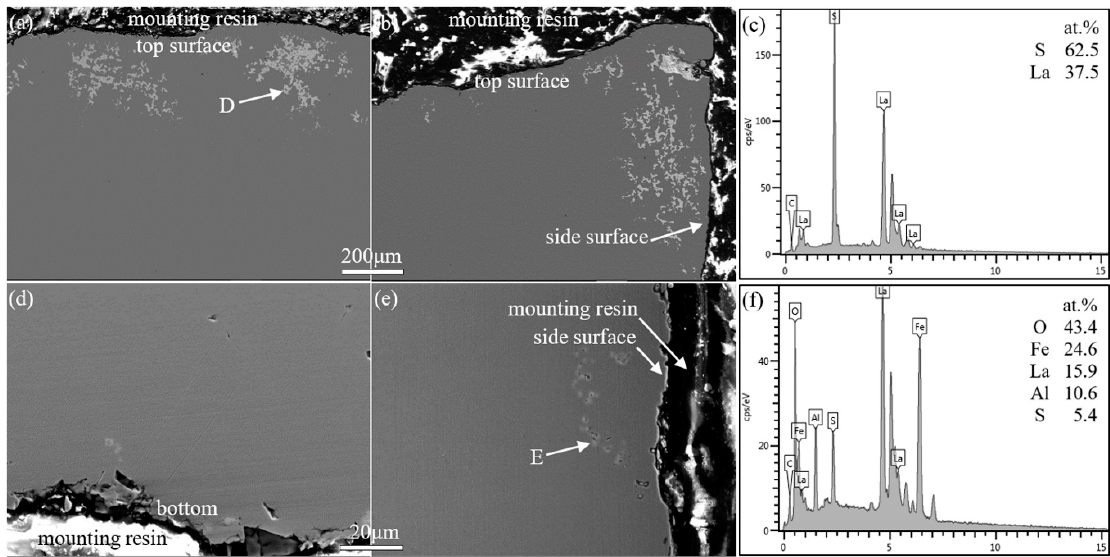
Figure 6. Morphologies, distribution, and compositions of inclusions on the profile of the ingot with the initial La addition of 0.054% (backscattered electron images). ( a ) Top surface of ingot; ( b ) corner between the top and side surfaces of ingot; ( c ) energy dispersive spectrum (EDS) of point D; ( d ) bottom of ingot; ( e ) side surface of ingot; ( f ) EDS of point E.